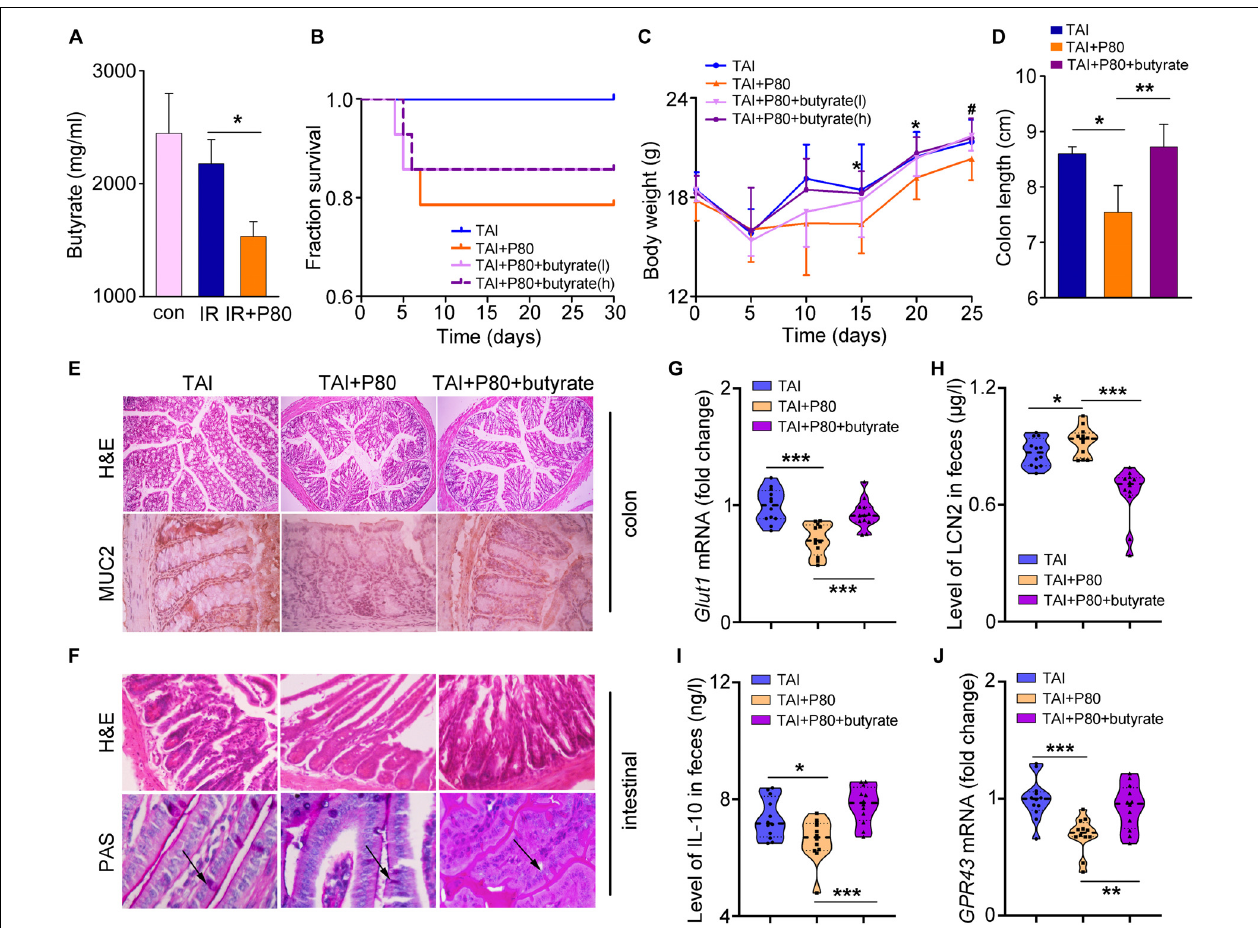
FIGURE 5 | Butyrate prevents the P80-aggravated irradiation injury. (A) The concentration of butyrate in different fecal samples was analyzed by HPLC. Significant differences are indicated: * p < 0.05; Student’s t -test, n = 12 per group. (B) Kaplan–Meier survival analysis of mice after irradiation was performed. p = 0.0102 between TAI and TAI+P80 group by log-rank test; n = 14 per group. TAI group was treated with water before and after TAI as control, TAI+P80 group was treated with P80 for 7 days before irradiation and water after irradiation, TAI+P80+butyrate group was treated with P80 before irradiation and different concentrations of butyrate after irradiation (low, 3.75 mg/ml; high, 7.5 mg/ml). (C) The body weight of mice was measured after 12 Gy TAI using two-way group ANOVA ( # p < 0.05 compared between TAI+P80 and TAI+P80+butyrate (l), * p < 0.05 compared between TAI+P80 and TAI+P80+butyrate (h); n = 14 per group. (D) The length of colon tissues was measured at 30 days after TAI. Significant differences are indicated: * p < 0.05, ** p < 0.01; Student’s t -test. (E) The morphology of the colon (upper panel) was shown by HE staining. Immunohistochemical showed expression of MUC2 in the colons of mice (lower panel). (F) The morphology of the small intestines was shown by HE and PAS staining. The arrows pointed to the goblet cells. (G) The expression level of Glut1 in small intestine tissues was examined by qRT-PCR. Significant differences are indicated: *** p < 0.001; Student’s t -test, n = 12 per group. (H) Fecal level of the inflammatory marker LCN2 was examined by ELISA. Statistically significant differences are indicated: * p < 0.05, *** p < 0.001; Student’s t -test, n = 12 per group. (I) The concentration of IL-10 in feces was examined by ELISA. Significant differences are indicated: * p < 0.05, *** p < 0.001; Student’s t -test, n = 12 per group. (J) The expression level of GPR43 in the colons was examined by qRT-PCR. Significant differences are indicated: ** p < 0.01, *** p < 0.001; Student’s t -test, n = 12 per